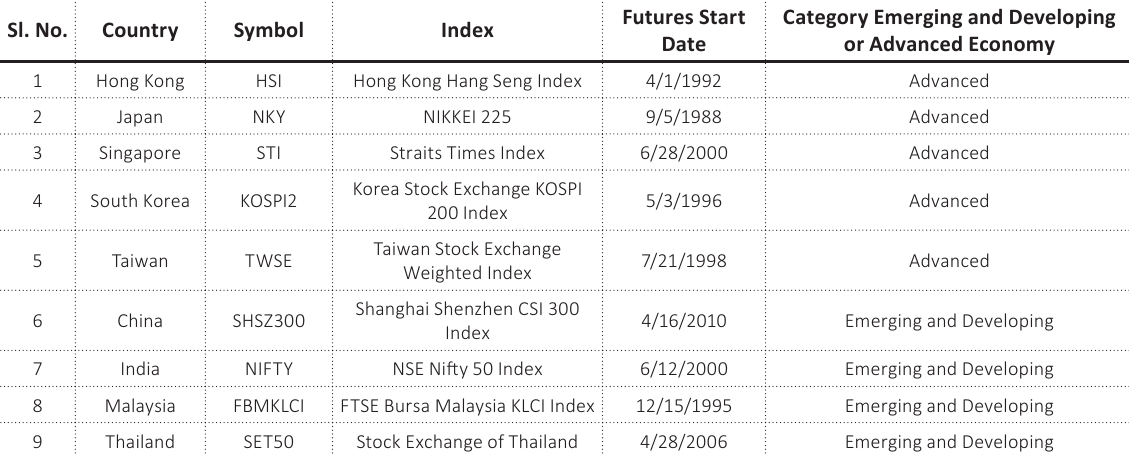
Table A1. List of indices considered for panel analysis Sl. No.